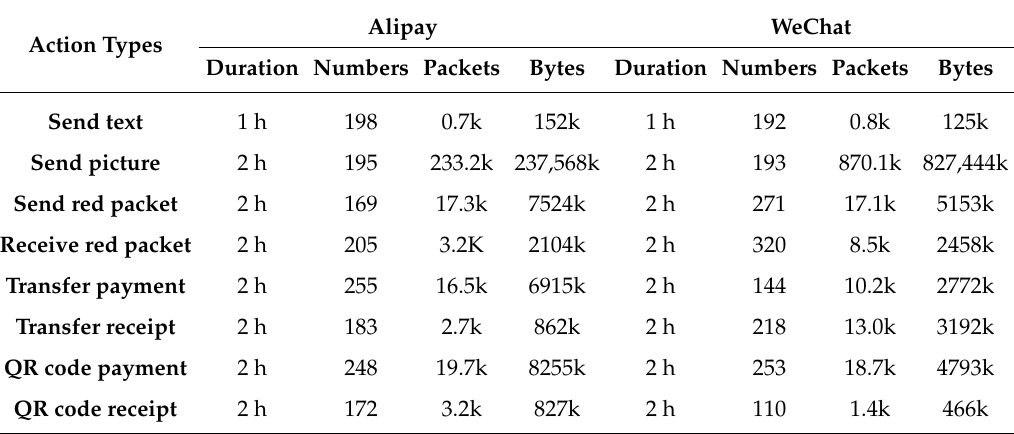
Table 3. Traffic data statistics of user actions on the Alipay app and the WeChat